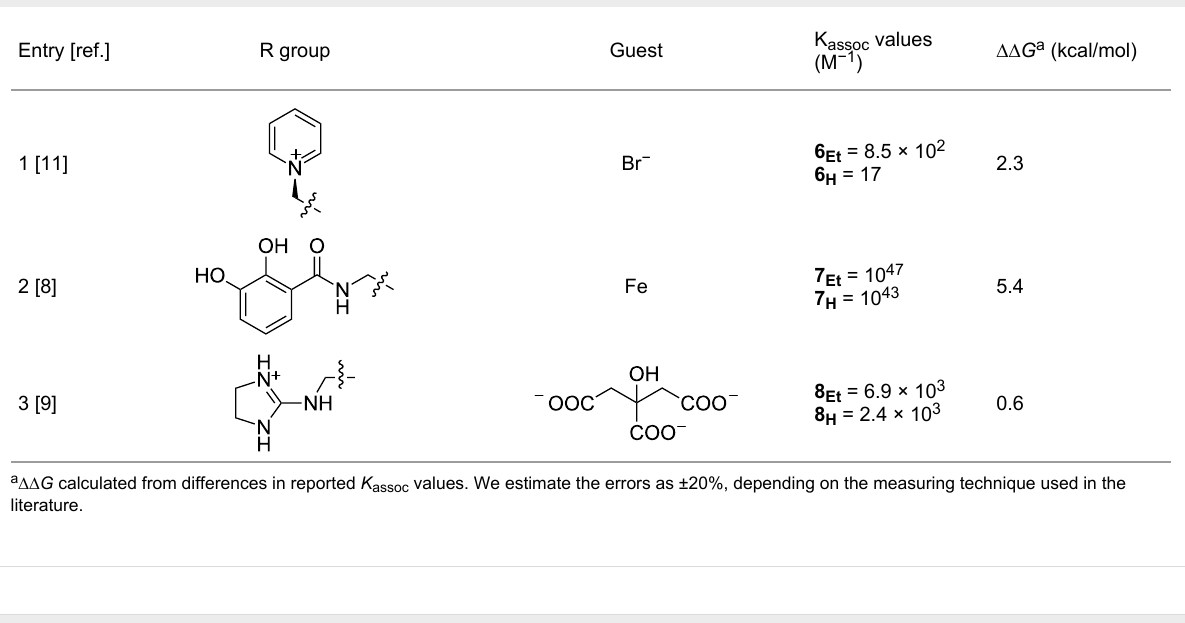
Table 2: Affinity comparisons of methyl-substituted and unsubstituted hosts.